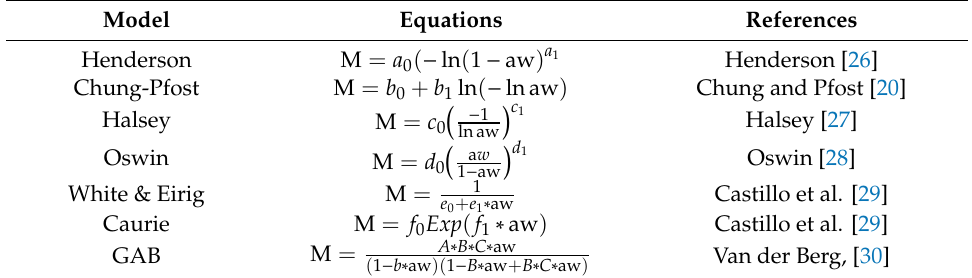
Table 2. Moisture sorption isotherms models fitted to the sorption